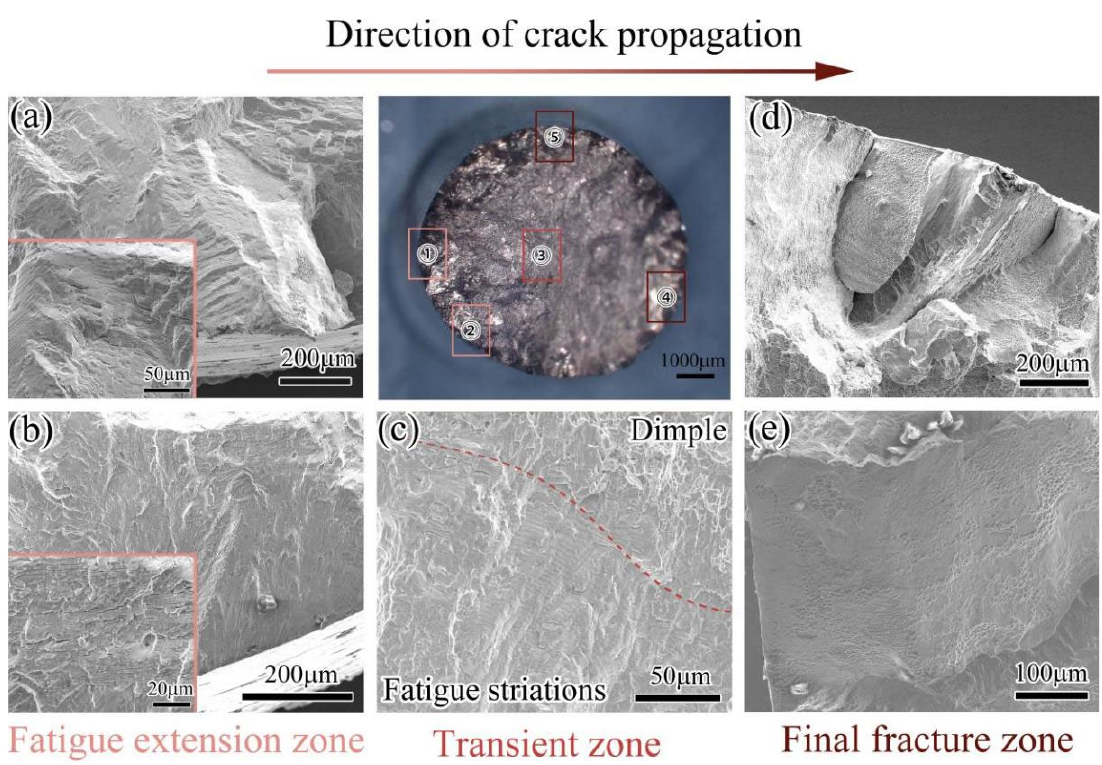
Figure 9. SEM fracture morphology of the LCF sample at 0.9% strain amplitude: ( a ) Region 1; ( b ) Region 2; ( c ) Region 3; ( d ) Region 4; ( e ) Region 5.